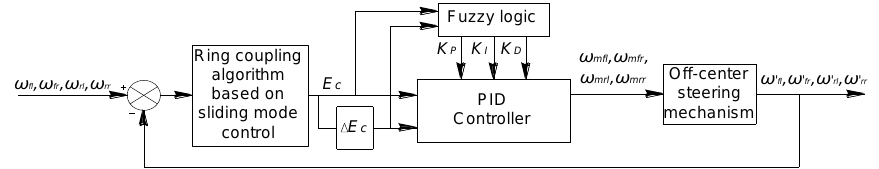
Figure 5. Fuzzy proportional integral derivative (PID) control structure for coupled motion. ω i is the input angular velocity of each off-center steering mechanism (OSM). ω mi is the angular velocity of each electric wheel. ω′ i the output angular velocity of each OSM.